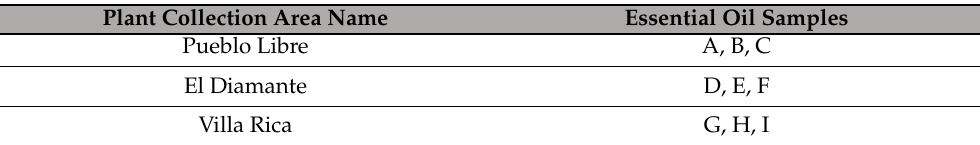
Table 4. Plant collection area and associated essential oil sample